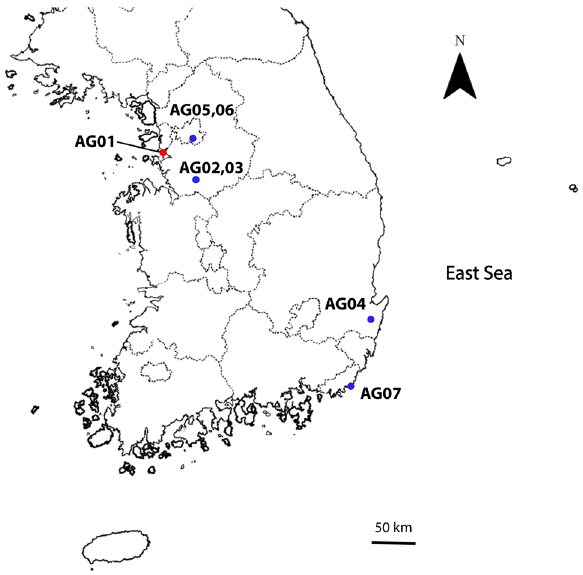
Figure 3. Map of sampling location from where 121 specimens of Asynapta groverae were collected in South Korea. Site of the first outbreaks of A. groverae (AG01) is shown in the red circle.